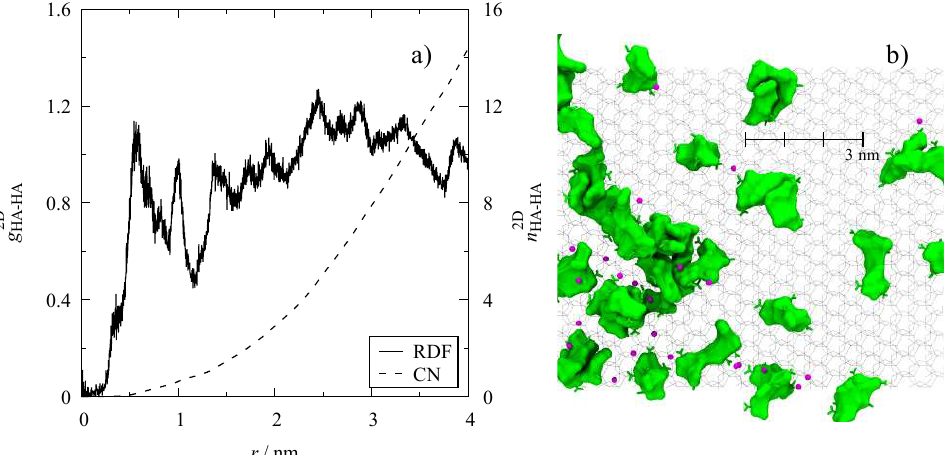
Figure 7. Lateral radial distribution function (RDF; g ij ) and running coordination number (CN) of HA’s COM on the aluminol side at distance r from the reference COM confined in 0 < z < 1.15 nm space ( a ). Top view ( xy –plane) of HA patches (green isosurfaces) adsorbed on the aluminol surface of kaolinite (gray lines) ( b ). Ca 2+ cations are presented as magenta balls.